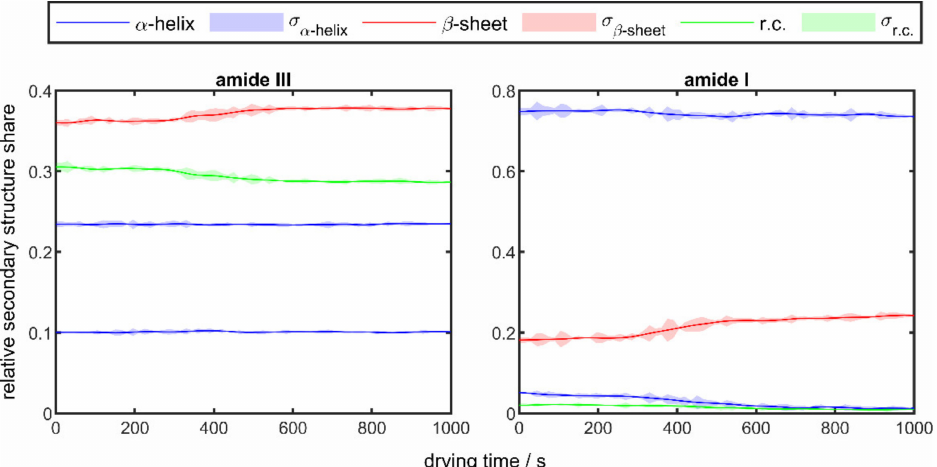
Figure 8. Temporal changes of the relative secondary structure shares in the amide I ( right ) and amide III ( left ) band of 10 wt% lysozyme droplets at a drying temperature of 50 ◦